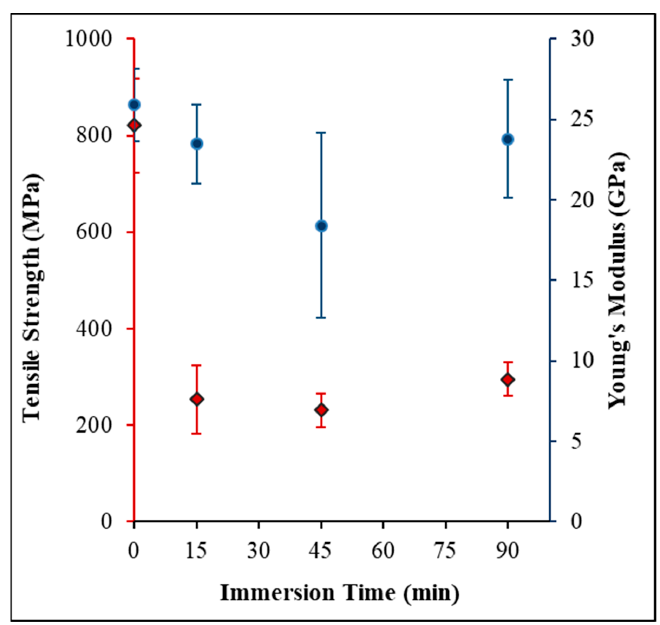
Figure 3. Mechanical properties: (circles: modulus, rhombus: strength).